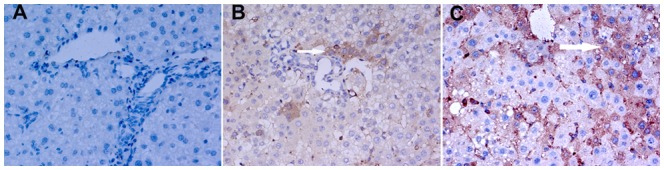
GPC3 expression of liver tissue in mice through Immunohistochemistry (400× magnification, allows indicate GPC3 expression cytolymph positive cells).A: The negative expression of GPC3 expression in control group mice liver; B: The small amount of positive expression of GPC3 was be seen in Maotai+ DEN group mice liver; C:The remarkable positive expression of GPC3 in ethanol+ DEN group mice liver.